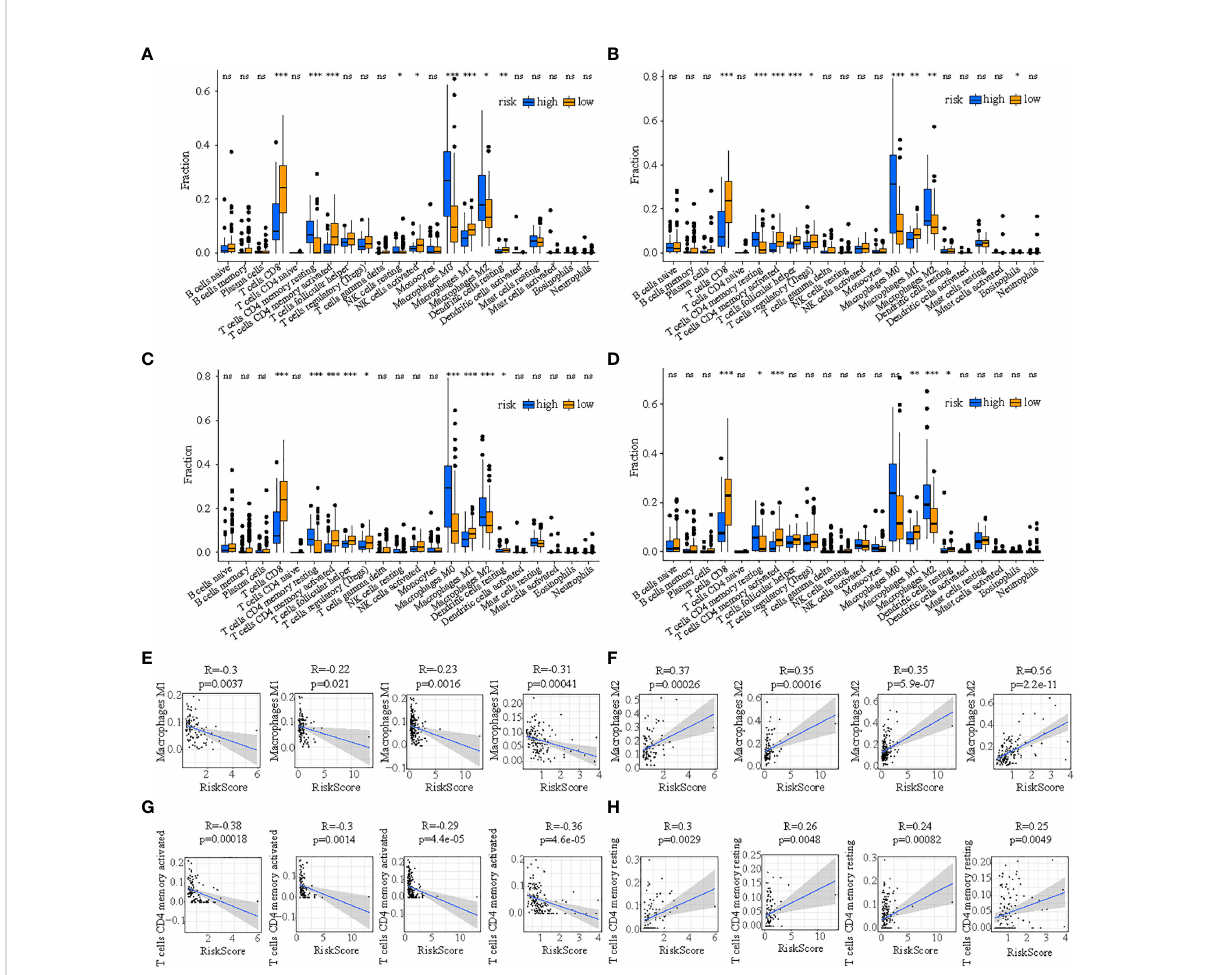
FIGURE 9 The discrepancy of tumor-in fi ltrating immune cells in two risk subpopulations in train (A) , test1 (B) , test2 (C) , and test3 (D) and the correlation between ICDRS-based risk score and the proportion of immune cells in the tumor immune environment in train (E) , test1 (F) , test2 (G) , and test3 (H) . (* indicates p <0.05; ** indicates p < 0.01; *** indicates p < 0.001; ns: